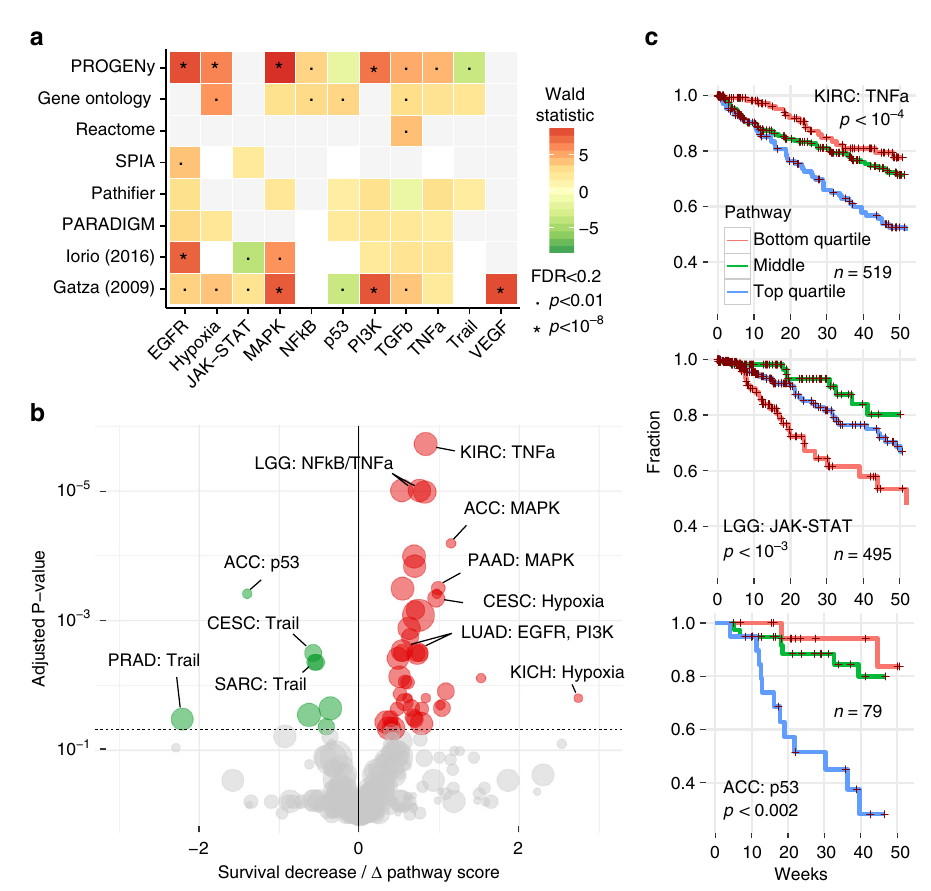
Fig. 5 Response signatures outperform pathway methods for patient survival. a Pan-cancer associations between pathway scores and patient survival. Pathways on the horizontal axis and different methods on the vertical axis. Associations of survival increase (green) and decrease. Signi fi cance labels as indicated. Shades correspond to effect size, p values as indicated. b Volcano plot of cancers-speci fi c associations between patient survival and inferred pathway score using PROGENy. Effect size on the horizontal axis. Below zero indicates increased survival (green), above decreased survival (red). FDR- adjusted p values on the vertical axis. Size of the dots corresponds to number of patients in each cohort. c Kaplan – Meier curves of individual associations for kidney (KIRC), low-grade glioma (LGG), and adrenocortical carcinoma (ACC). Pathway scores are split in top and bottom quartiles and center half. Lines show the fraction of patients (vertical axis) that are alive at a given time (horizontal axis) within one year. P values for discretized